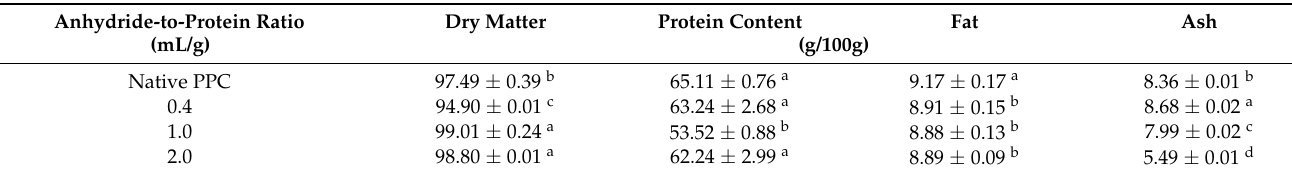
Table 1. Characteristics of native and acetylated